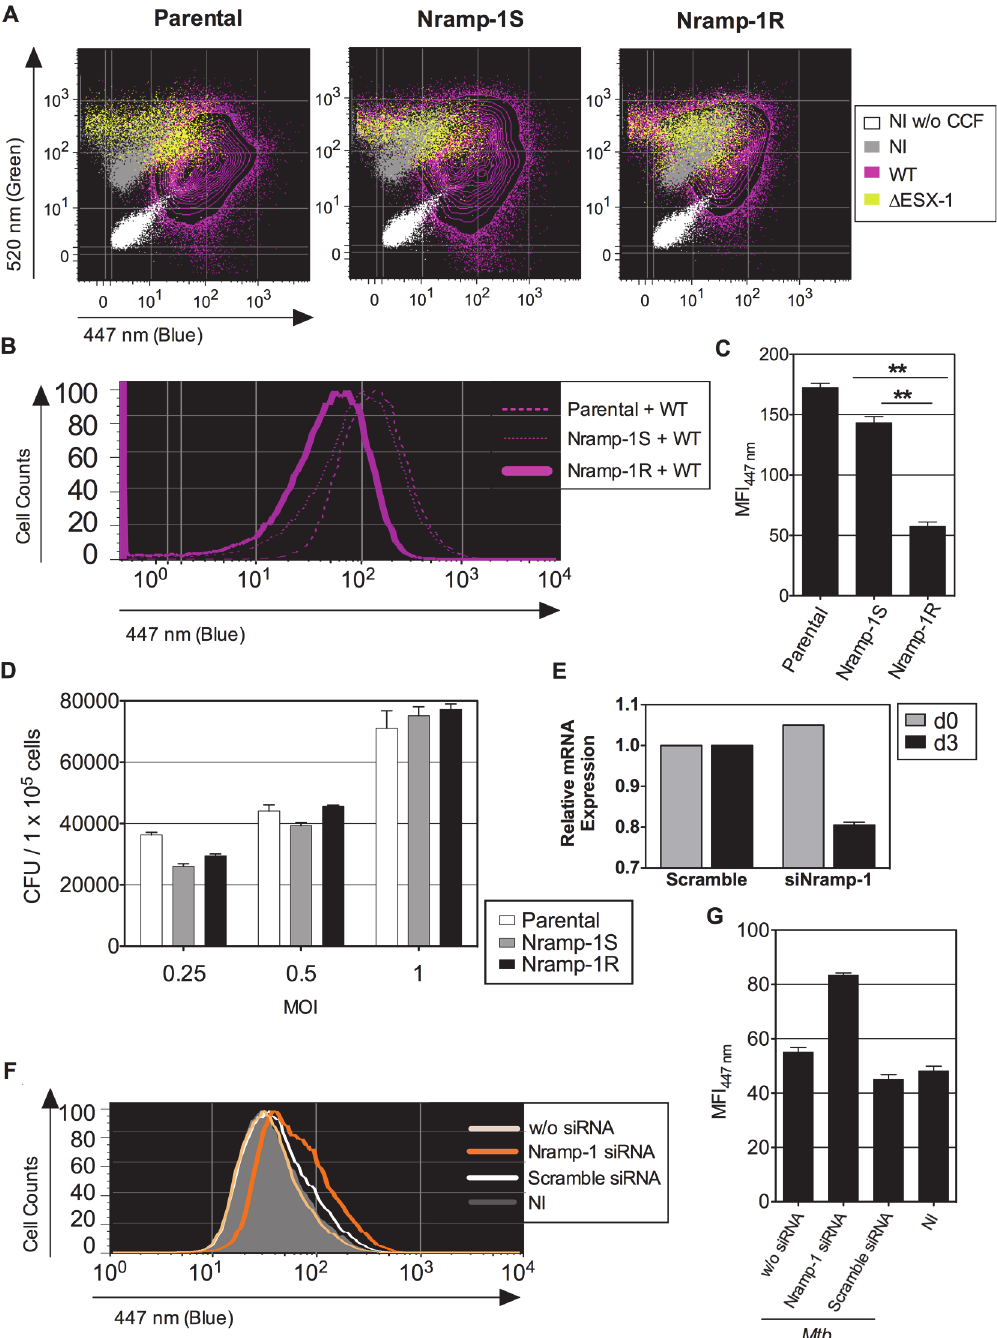
Fig 4. Host Nramp-1 transporter counteracts the phagosomal rupture in Mtb -infected M Φ . (A) Raw264.7 cells, parental or transfected with non- functional nramp-1S or functional nramp-1R allele, were infected with Mtb , WT or Δ ESX-1 (MOI = 1). At 3 dpi, phagosomal rupture was monitored in CD11b + cells. (B, C) The blue CCF-4 signal overlays (B) and MFI 447 nm (C) are plotted for different Raw264.7 cell lines infected with Mtb WT. ** = statistically significant, as determined by the Student's t test, p < 0.001. (D) Mycobacterial loads in different Raw264.7 cell lines, infected with various MOI of WT Mtb , as determined at 3 dpi. (E-G) Raw264.7:: nramp-1R were transfected with Nramp-1-specific or scramble siRNA and the effective gene silencing was checked 3 days later by qRT-PCR (E). The siRNA-treated Raw264.7:: nramp -1R cells were then infected with WT Mtb (MOI = 1) and studied for phagosomal rupture at 3 dpi. The blue CCF-4 signal (F) and the MFI 447 nm (G) are plotted. The results are representative of at least 3 experiments.